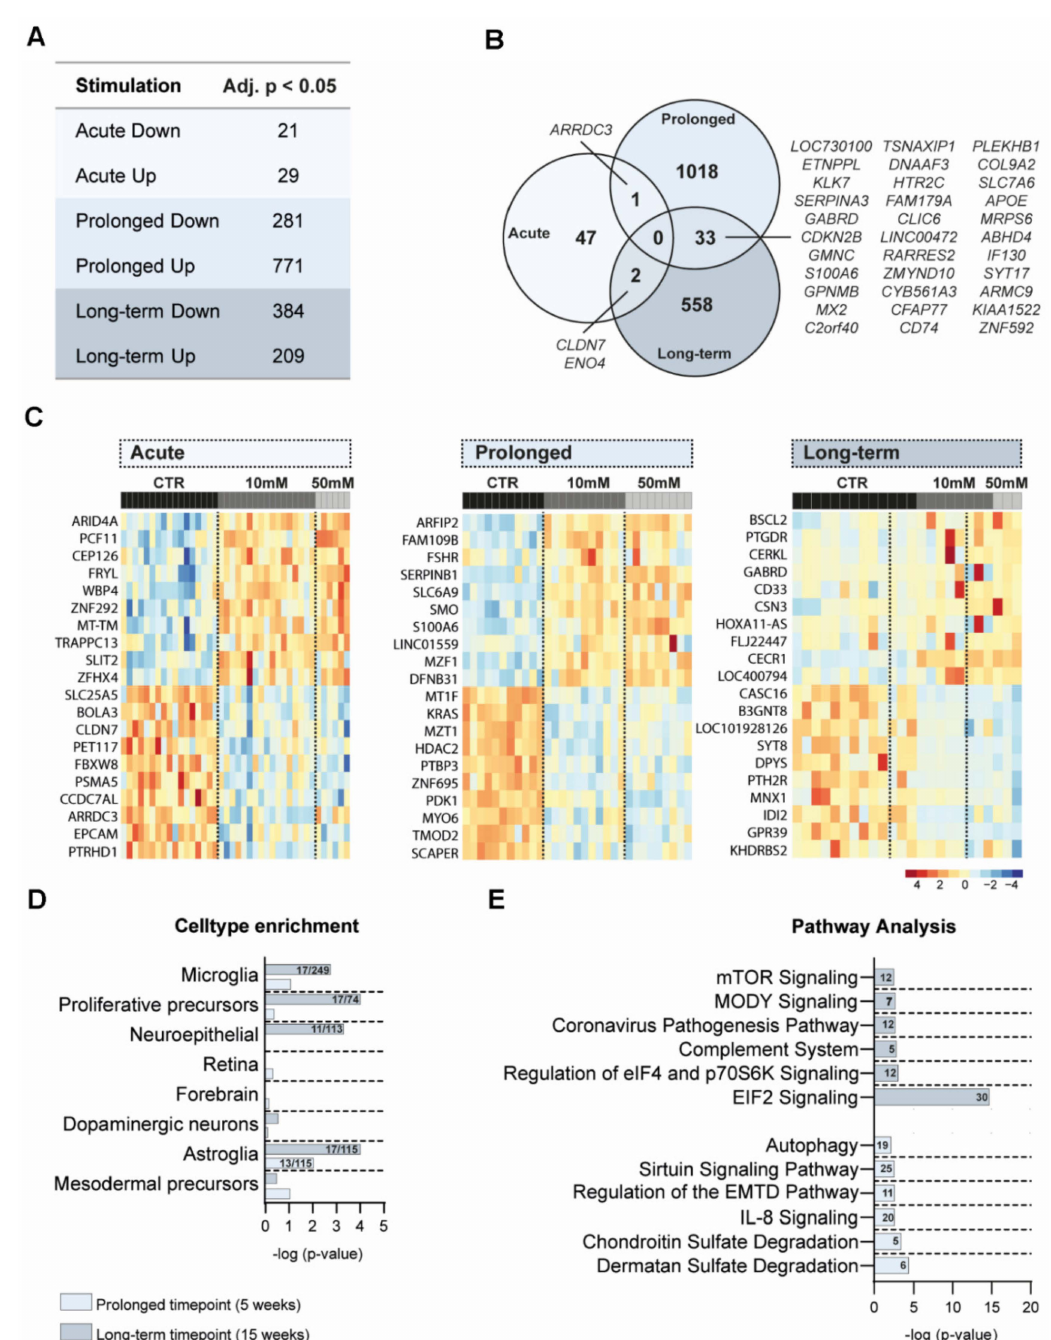
Figure 4. Altered gene transcription in response to AA exposure in cerebral organoids. ( A ) Table providing an overview of the number of significantly differentially expressed genes after acute, prolonged, and long-term AA exposure. ( B ) Venn diagram showing the overlap between